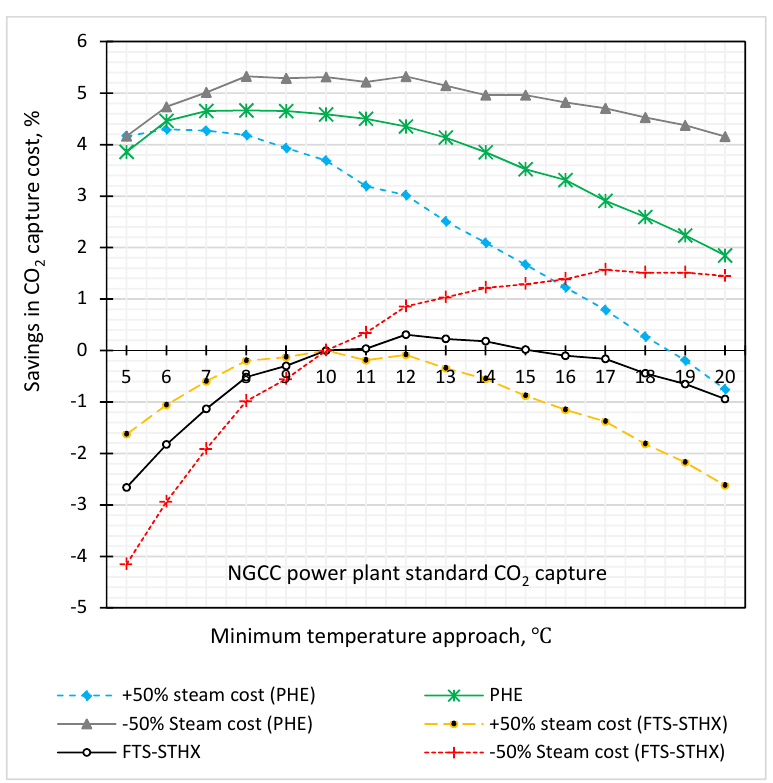
Figure 19. Sensitivity analysis of steam cost on the energy and heat exchanger costs trade–off analyses at different ∆ T min for different heat exchanger types in a standard CO 2 capture from cement flue gas.